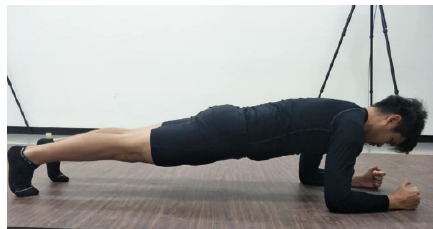
Figure 1. Acceptable plank technique. PC: The plank technique is acceptable.